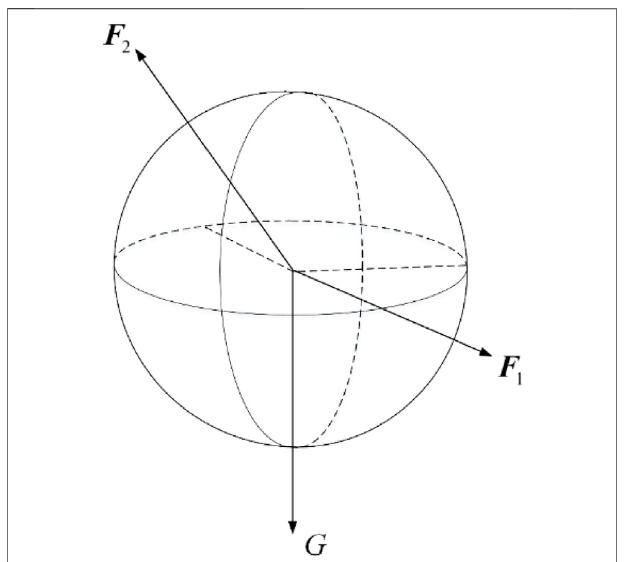
FIGURE 4 | Mechanical model of abrasive particle.